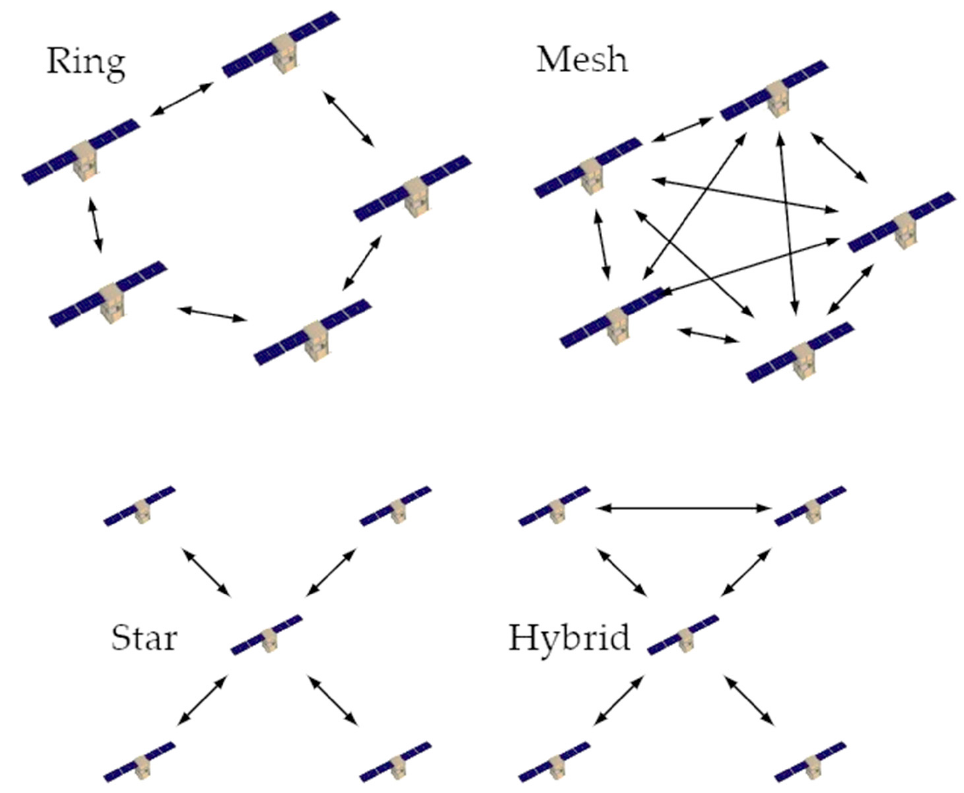
Figure 2. Inter-Satellite Link (ISL) topologies within the DSS, adapted from